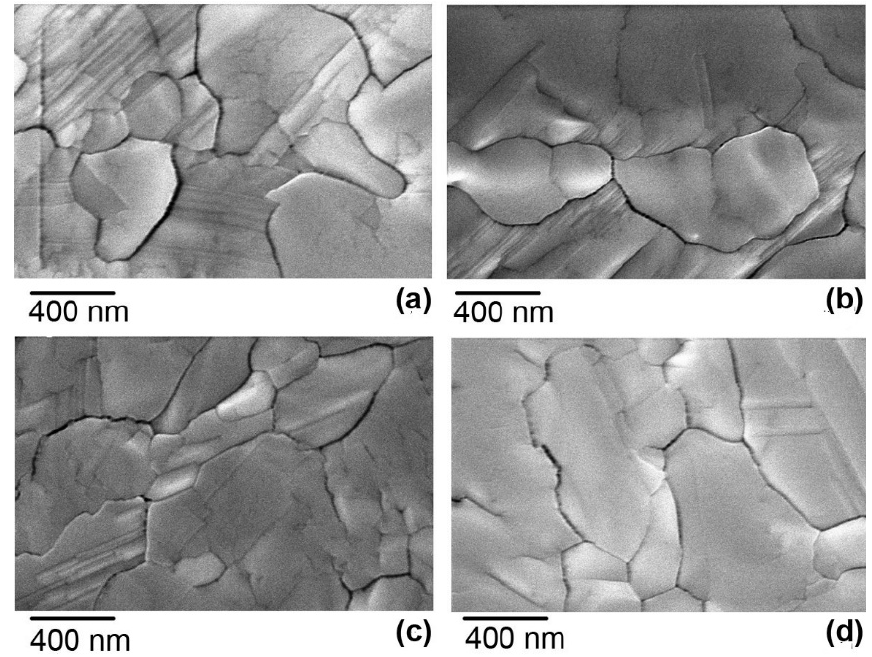
Figure 4. Surface SEM images of perovskite films grown on different types of titanium dioxide layers: ( a ) Film A on the c-TiO 2 layer, ( b ) Film B on the mp-TiO 2 layer/c-TiO 2 , ( c ) Film C on the compact ALD-TiO 2 layer, and ( d ) Film D on the mp-TiO 2 layer/ALD-TiO 2 . The cross-sectional SEM images of the same perovskite films are shown in Figure